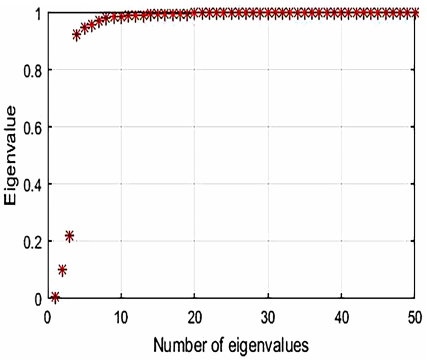
Figure 3. The Laplacian matrix eigenvalues of a signal that is sensed from the monitored area of Figure